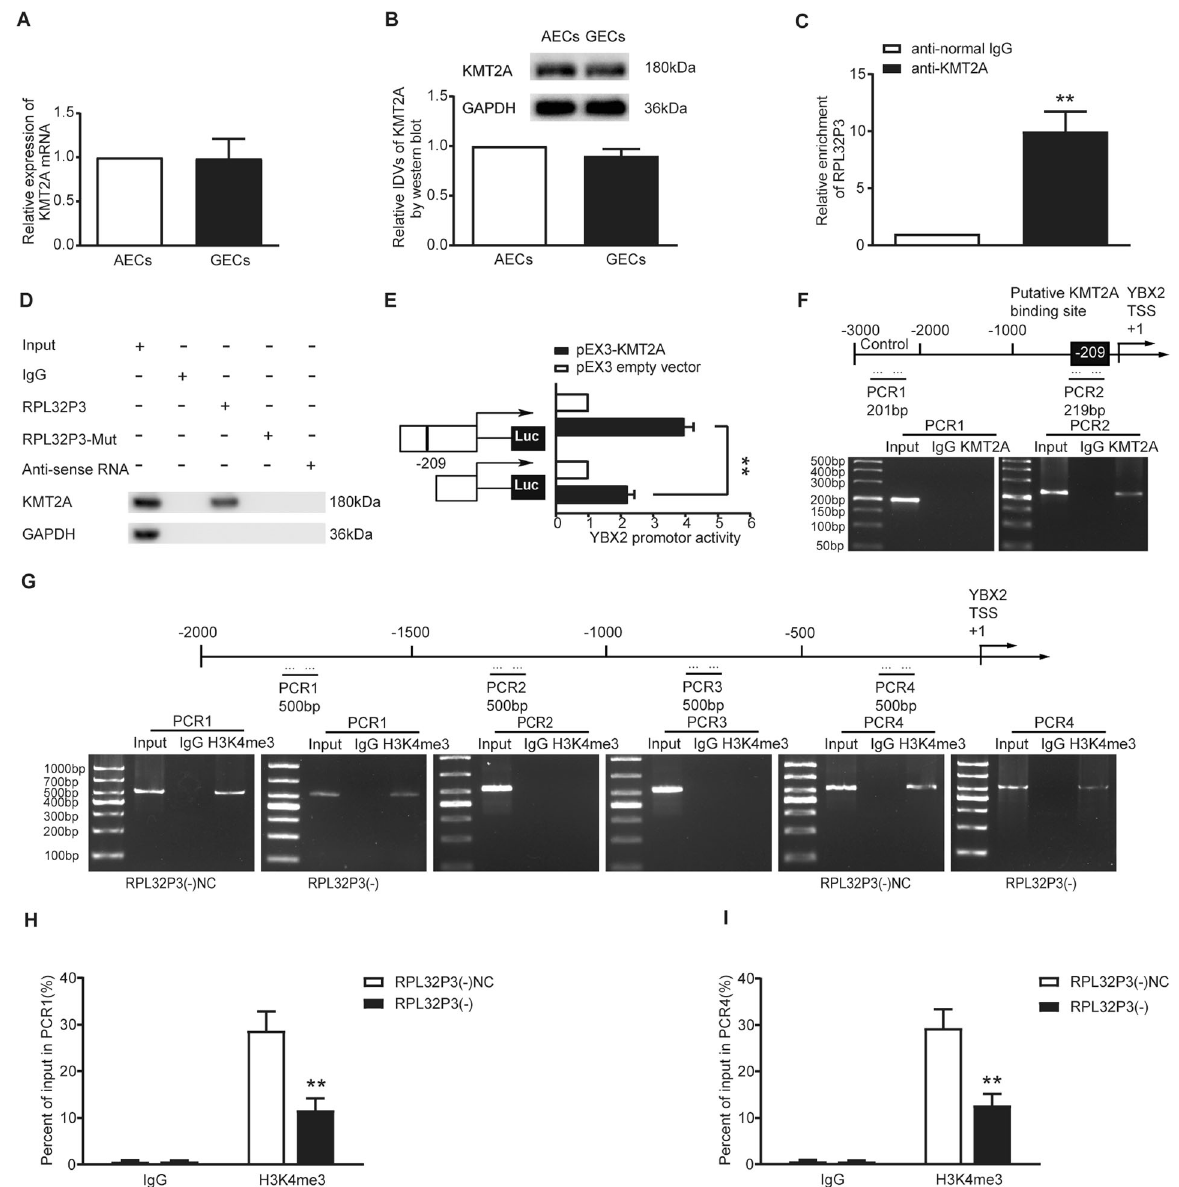
Fig. 3 RPL32P3 bound to KMT2A to promote H3K4me3 modi fi cation in the YBX2 promoter region. A , B The mRNA and protein expression of KMT2A in AECs and GECs were detected by qRT-PCR and western blot. Data represent mean ± SD ( n = 3, each). C Enrichment of RPL32P3 in KMT2A immunoprecipitates was measured by RNA immunoprecipitation (RIP) assay. Relative enrichment was measured using qRT-PCR. Data represent means ± SD ( n = 3, each). ** p < 0.01 vs. anti-normal IgG group. D RNA pull-down assay con fi rmed that RPL32P3 bound to KMT2A. KMT2A and GAPDH protein levels in immunoprecipitates with RPL32P3 RNA were evaluated by western blot. E Schematic diagram of different reporter plasmids and relative dual-luciferase activities of YBX2. The left side showed the deletion site on YBX2 promoter, and the right side showed the decrease of reporter vector activity after the deletion of the putative binding site. Data represent means ± SD ( n = 5, each). ** P < 0.01. F Schematic diagram of YBX2 promoter region from transcription start site (TSS) to 3000 bp upstream in chromatin immunoprecipitation (ChIP) assay. TSS was designated as + 1. Immunoprecipitated DNA was ampli fi ed by PCR. Normal rabbit IgG was used as a negative control. G YBX2 promoter region was divided into four parts, each part of which was 500 bp on average, from TSS to 2000 bp upstream. H3K4me3 was enriched in PCR1 and PCR4. And reaction bands were detected in RPL32P3(-)NC and RPL32P3(-) groups respectively. H , I qRT-PCR analysis for the enrichment value of H3K4me3 immunoprecipitated chromatin of PCR1 and PCR4 was calculated. IgG immunoprecipitated chromatin was used as a negative control. Data represent mean ± SD ( n = 3, each group). ** p < 0.01 vs. RPL32P3(-)NC group. start site (TSS), and each part was 500 bp. H3K4me3 antibody and remarkably increased after co-transfection with pEX3-KMT2A. And normal rabbit IgG were used to precipitate the protein-DNA the deletion of the putative binding site with KMT2A ( − 209 bp) complex, then the precipitated DNA was used for PCR. The results led to a reduction of YBX2 promoter activity (Fig. 3E). Chromatin showed that H3K4me3 was enriched at − 2000 to − 1500 bp immunoprecipitation (ChIP) assay showed that there was an (PCR1) and − 500 bp to TSS (PCR4) of the YBX2 promoter (Fig. 3G). interaction of KMT2A with the putative binding site of YBX2 (Fig. Afterward qRT-PCR was performed to measure the percentage of 3F). In a further ChIP assay, the YBX2 promoter region was divided PCR1 and PCR4 products ampli fi ed with the DNA precipitated by into four equal parts from 2000 bp upstream to the transcription Cell Death Discovery (2021)